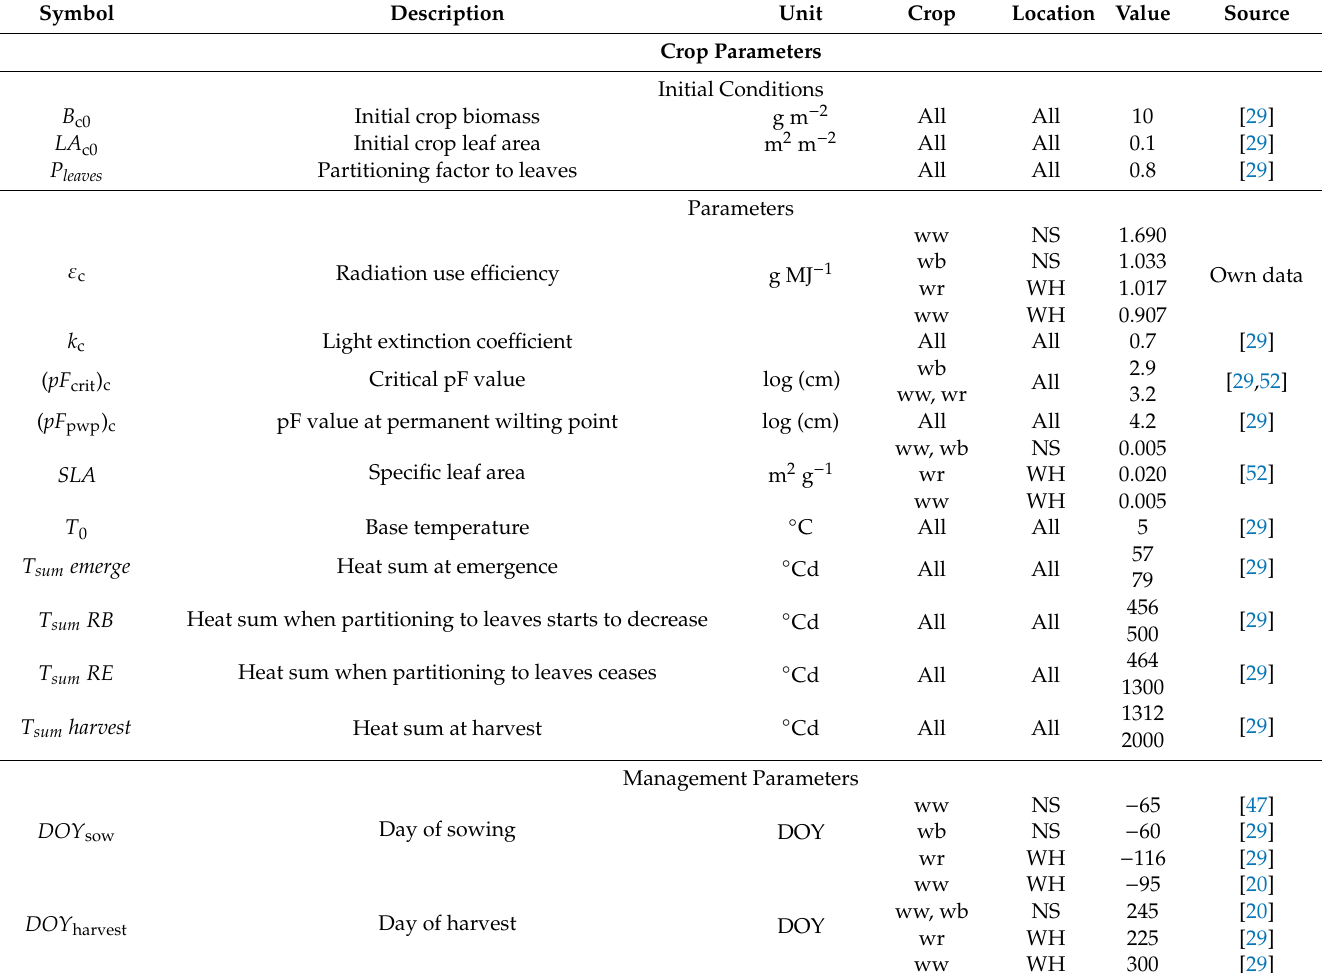
Table A2. Crop parameter values used for the parametrization of the Yield-SAFE model.